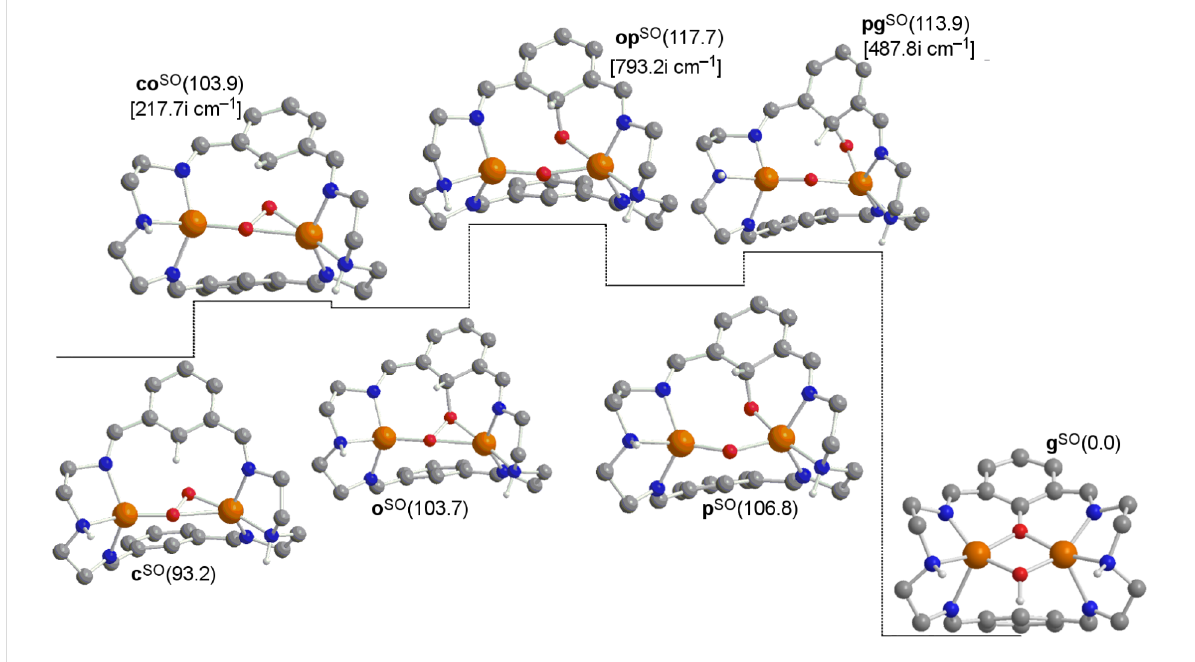
Figure 7: Computed structures for a potential alternative pathway c → g of the σ * mechanism (some H atoms omitted for clarity). Gibbs energies rela- tive to product g (in kcal·mol − 1 ) in solution are given in parentheses. Calculated imaginary frequencies for transition structures are given in brackets. Superindex SO (open-shell singlet) refers to the multiplicity of the ground state.